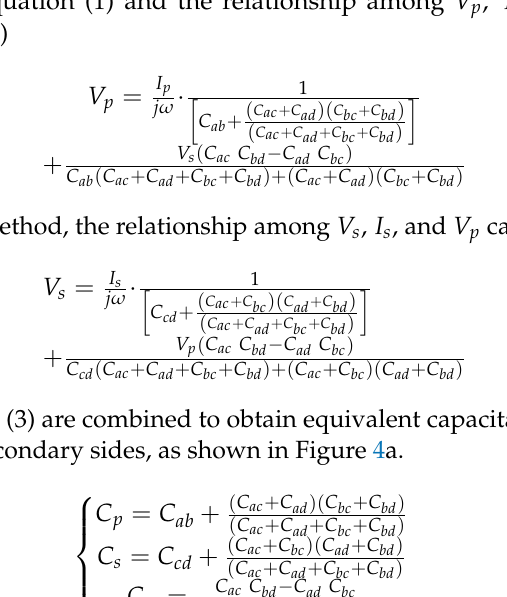
Figure 4. Circuit model of the capacitive coupler. ( a ) Basic illustration of the capacitive coupler. ( b ) Pi model.